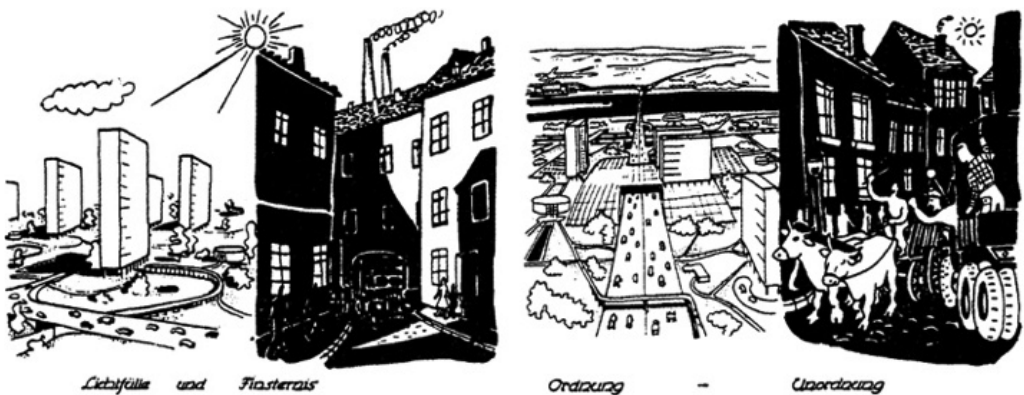
Figure 26. Reconstruction of Mainz, 1946–1948, Marcel Lods. Source: Cohen and Frank